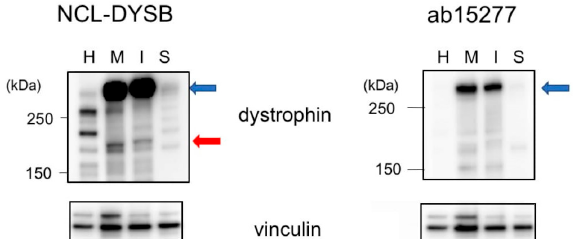
Figure 4. Identification of Dpm234 protein by Western blotting assay. Lysates of iPS-derived MiraCell ® cardiomyocytes and iCell ® cardiomyocytes 2 , as well as lysates of normal cardiac and skeletal muscles, were analyzed by Western blotting. Antibody to the N-terminal region (NCL-DYSB) of dystrophin yielded a band between 250 kDa and 150 kDa size markers (red arrow) in the lysates of MiraCell ® (M) and iCell ® (I) cells (left). In contrast, antibody to the C-terminal region of dystrophin (ab15277) did not bind to this band in MiraCell ® cardiomyocytes and iCell ® cardiomyocytes 2 (right). Both antibodies, however, bound to Dp427m in cardiac (H) and skeletal (S) muscles (blue arrows). Antibody to vinculin was the loading control (bottom). Size markers are shown on the left